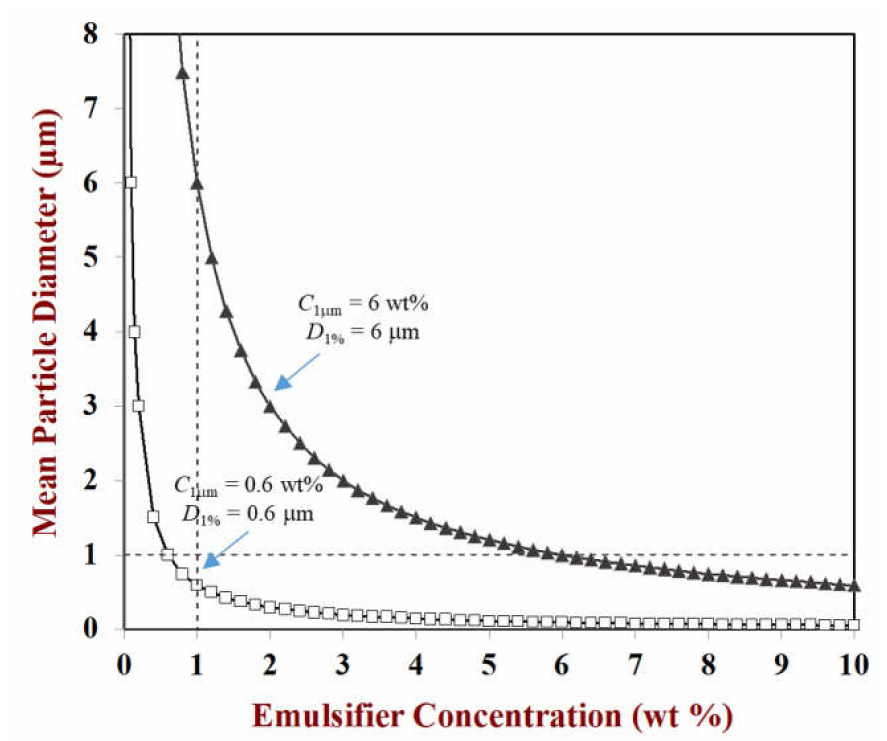
Figure 15. The performance of an emulsifier at creating small droplets during homogenization can be determined by measuring the emulsifier concentration ( C 1 µ m ) required to form oil-in-water emulsions (10% oil) with droplets of a specified mean diameter (e.g., d 32 = 1 µ m) and the mean droplet diameter ( d 1% ) that can be achieved when using a constant emulsifier concentration (1% w / w ). Curves are predictions made using Equation